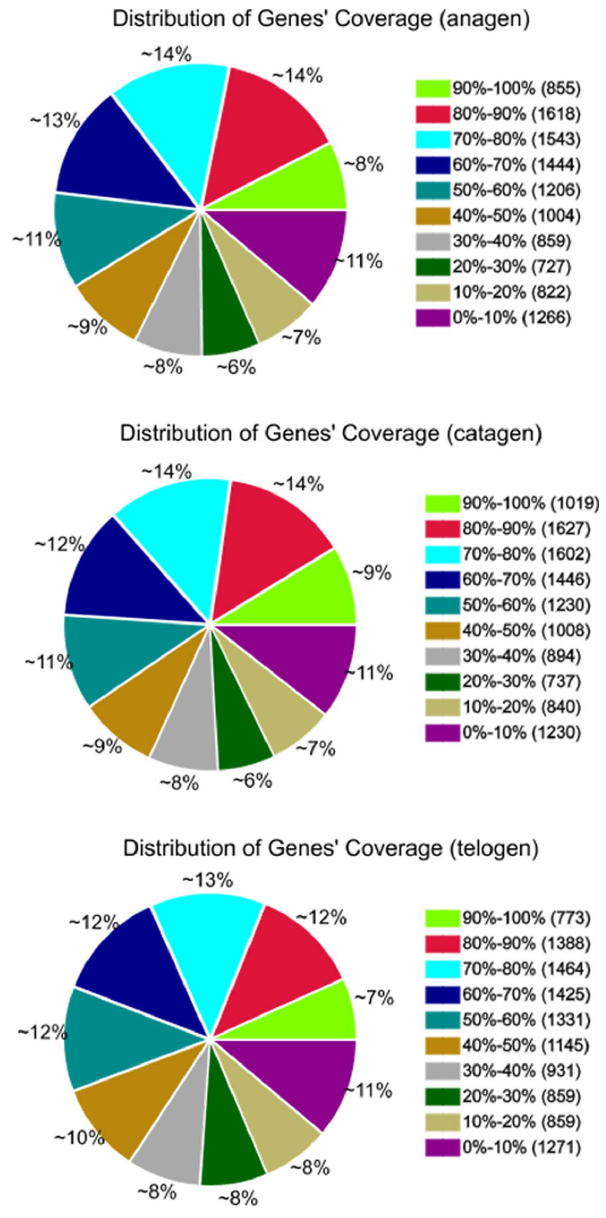
Figure 2. Percent of coverage representing the percentage of genes expressed at each of the stages. The distribution of distinct reads over different read abundance categories showed similar patterns for all the three RNA-Seq libraries. The similarity distribution had a comparable pattern with about 20% of the sequences having an 80% similarity, while approximately 80% of the hits had a similar range.